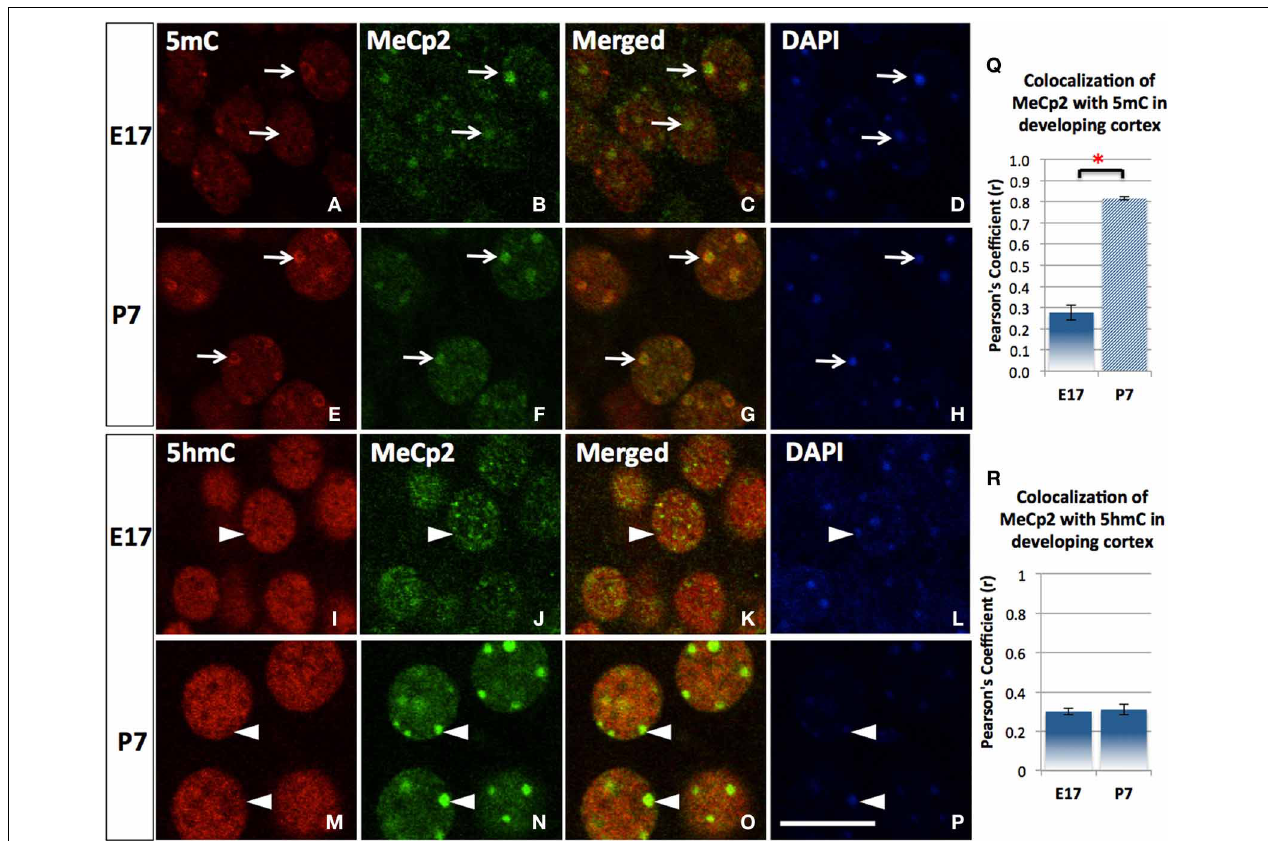
FIGURE 4 | The transitional association of MeCP2 from 5mC to 5hmC during neuronal maturation. The association of MeCP2 with 5mC is consolidated as neurons mature shown in the cortex. Nuclear distribution of methyl-binding protein 2 (MeCP2) is homogeneous and mildly associated with 5mC (A–D) at E17 but greatly increased at P7 in cortex (E–H) . Pearson’s Coefficient (r) for co-localization was shown in the chart (Q) . In contrast, the homogeneously (euchromatic) distributed MeCP2 colocalized with 5hmC at